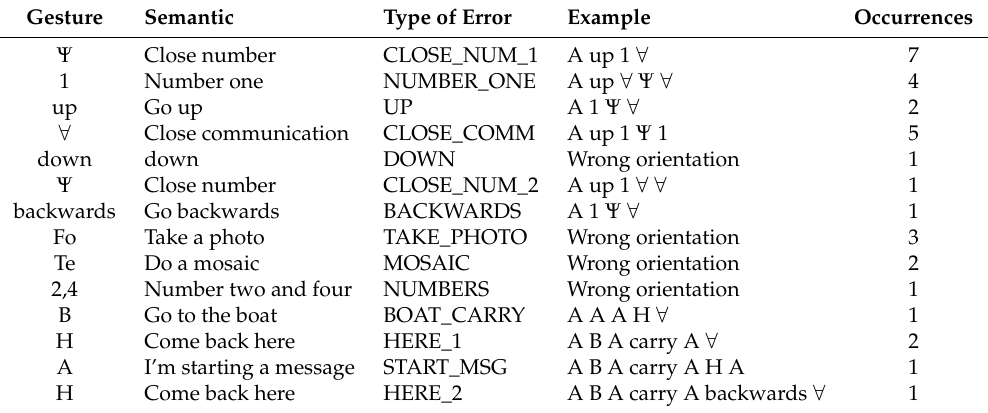
Table 3. Summary of the observed